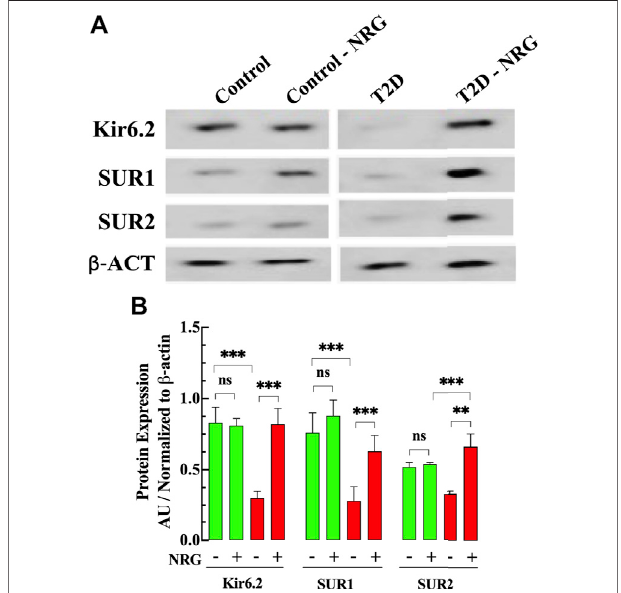
FIGURE 6 | Naringin increases KATP protein expression in diabetic cardiac tissue. (A) Representative Western blot bands of Kir6.2, SUR1, and SUR2 subunits expressions in ventricular tissues from naringin treated and untreated control and T2D mice. (B) Densitometric analysis of the expression of Kir6.2, SUR1, and SUR2 subunits in T2D show a signi fi cant downregulation compared to control tissue (64, 63, and 37%, respectively). Naringin treatment signi fi cantly increased the expression of Kir6.2 (173%), SUR1 (130%), and SUR2 (100%) subunits compared with untreated T2D ventricularhomogenate.TheSUR2 expression innaringintreatment-T2Dwas greater than control by 26% and control naringin-treated. by 22% ( p < 0.001). No effect on K ATP channels subunits in control ventricular tissues was observed. Data were normalized to housekeeping protein ß-actin and expressed as means ± S.D. n mice (cid:1) 3, n westerns (cid:1) 3 – 4. Statistical analysis was doneusingpairedStudent ’ sindependent t -test,ns p > 0.05,** p < 0.01,*** p <